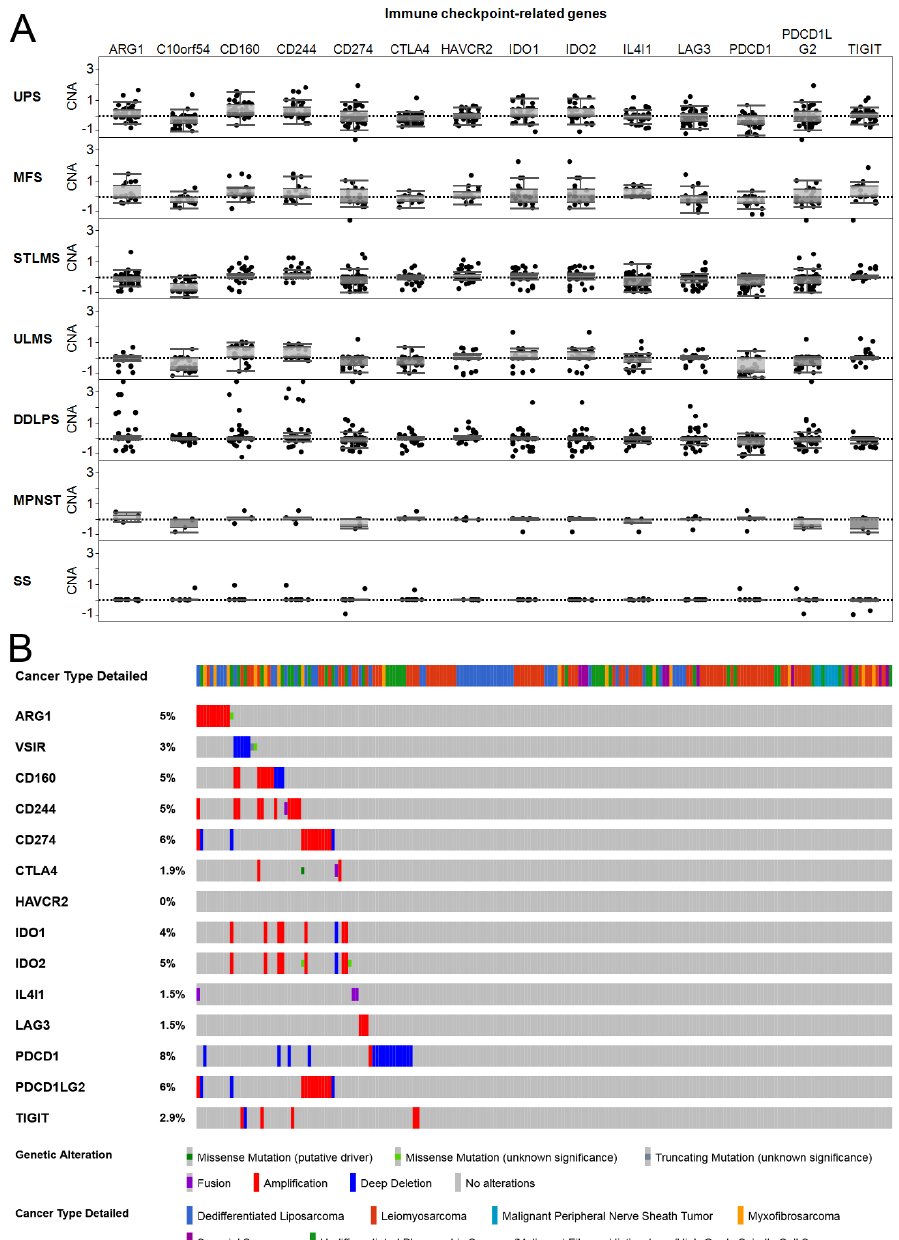
Figure 6. There are low rates of copy number alterations (CNAs) ( A ) and mutations ( B ) of immune checkpoint-related genes in soft tissue sarcomas. checkpoint-related genes in soft tissue